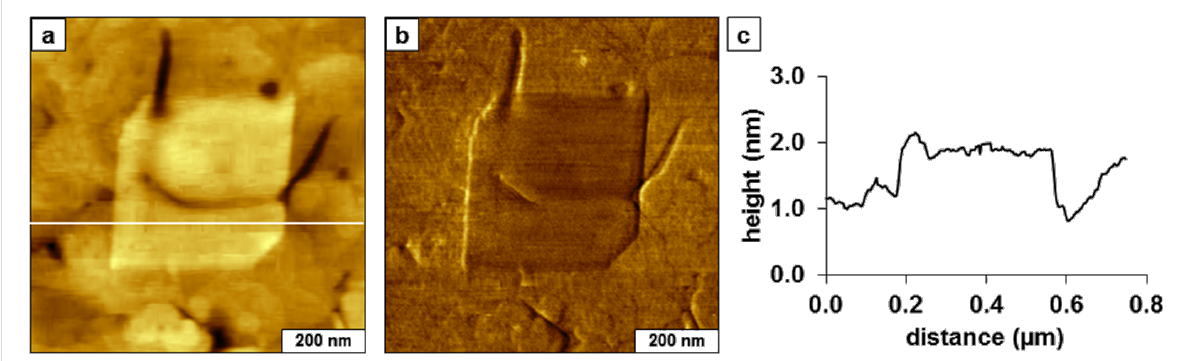
Figure 5: Nanografting of octadecanethiol (ODT) within a densely-packed TMMH matrix. (a) Topography image acquired in contact mode; (b) corres- ponding lateral force image. (c) Height profile taken across the square pattern in (a).